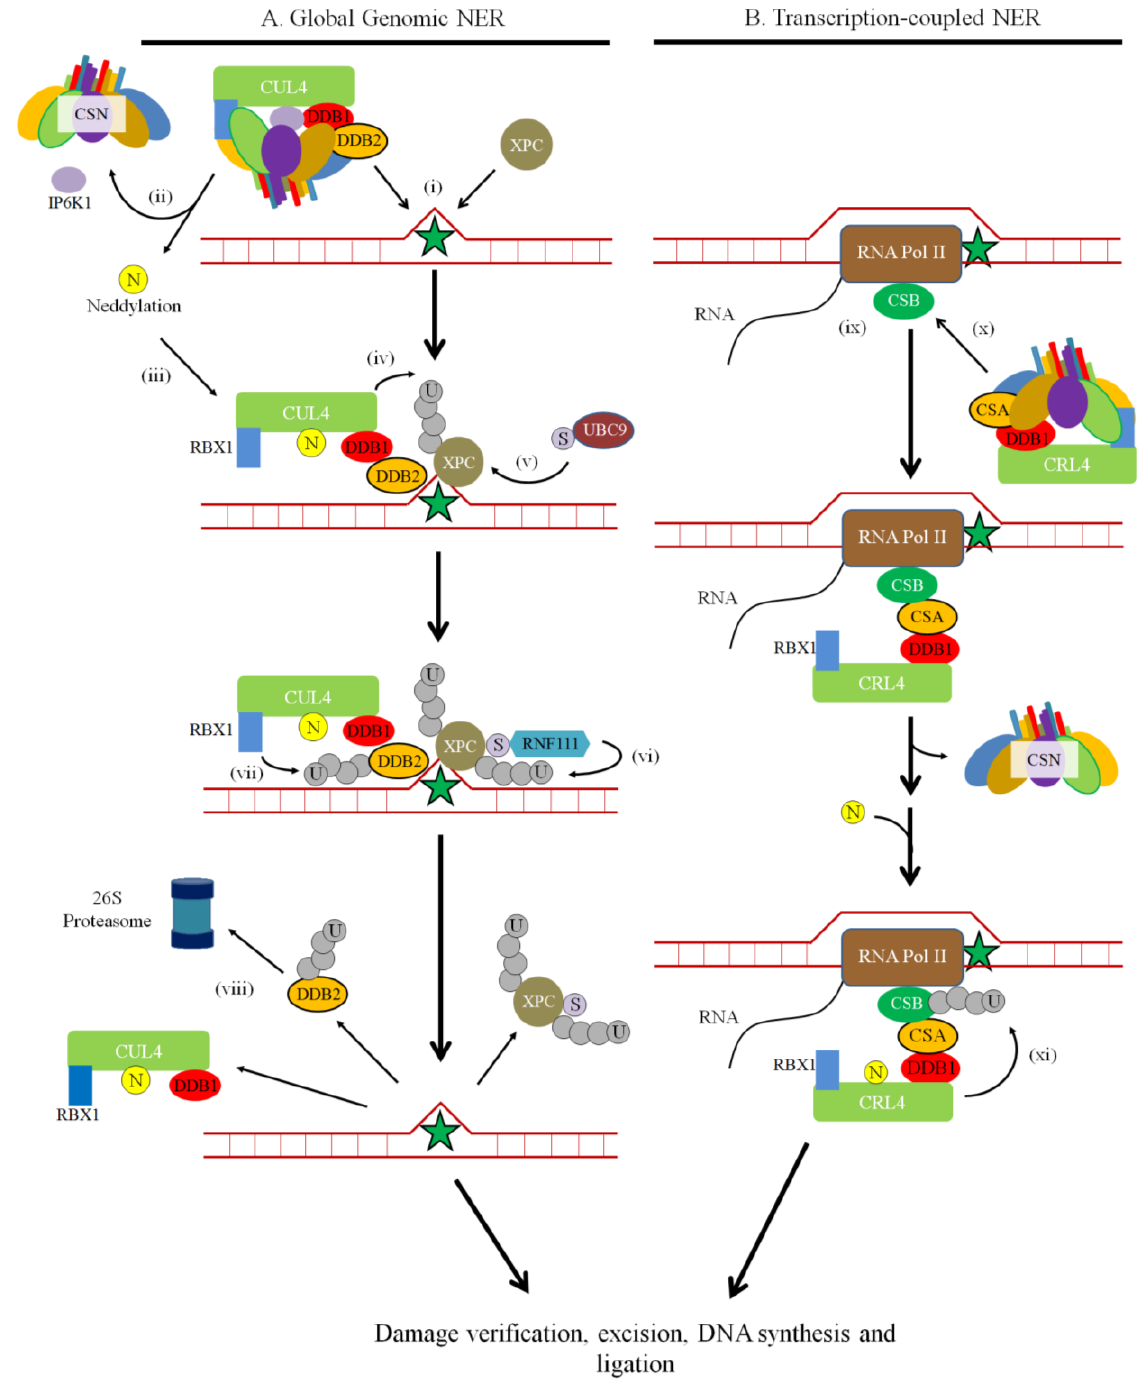
Figure 7. The Role of the CSN and Neddylation in the Initial Steps of NER. Cells use nucleotide excision repair to remove bulky lesions on DNA. ( A ) In GG-NER, XPC-RAD23 or DDB1-DDB2 recognizes the lesions (indicated by the star) (i). The CSN dissociates from CRL4 with the assistance of IP6K1 (ii), which is thought to promote NEDD8 (N) conjugation and CRL4 activation (iii). DDB1-DDB2 forms a complex with CUL4 and RBX1 to ubiquitylate XPC, which recruit repair proteins involved in subsequent steps in GG-NER (iv). XPC is SUMOylated by UBC9 (v), which promote ubiquitylation at Lys63 by RNF111 (vi) and dissociation from the DNA. Additionally, CRL4-DDB1